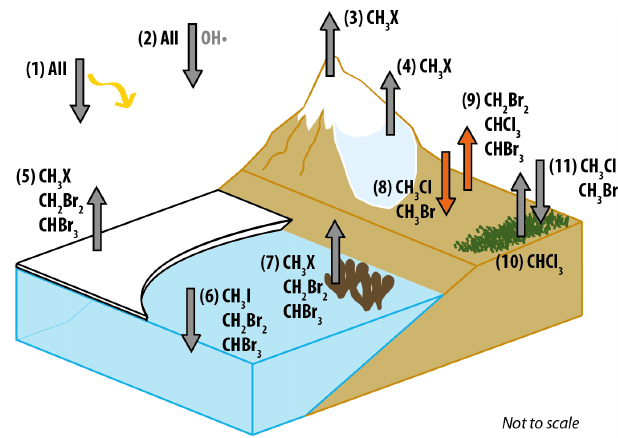
Figure 7. Schematic diagram summarising natural sources and sinks for the six halocarbons of interest in polar regions with fluxes measured in this paper (8 and 9) highlighted in orange. The sources and sinks are as follows: (1) UV photolysis sink, (2) reaction with (cid:113) OH sink, (3) photochemistry in snow source, (4) microbial activity in snow source, (5) sea ice microalgae source, (6) open-ocean sink, (7) macroalgae source, (8) forefield sink, (9) forefield source, (10) tundra source, (11) tundra sink. (CH 3 X = CH 3 Cl, CH 3 Br, CH 3 I). References for the presence of each flux are as follows: 1, 2 (see Montzka et al., 2011, for review), 3 (Swanson et al., 2007), 4 (Re- deker et al., 2017), 5 (Laturnus et al., 1998; Sturges et al., 1993), 6 (Stemmler et al., 2014; Ziska et al., 2013), 7 (Laturnus, 1996, 2001), 8 and 9 (this study), 10 (Albers et al., 2017; Rhew et al., 2008), 11 (Rhew et al.,